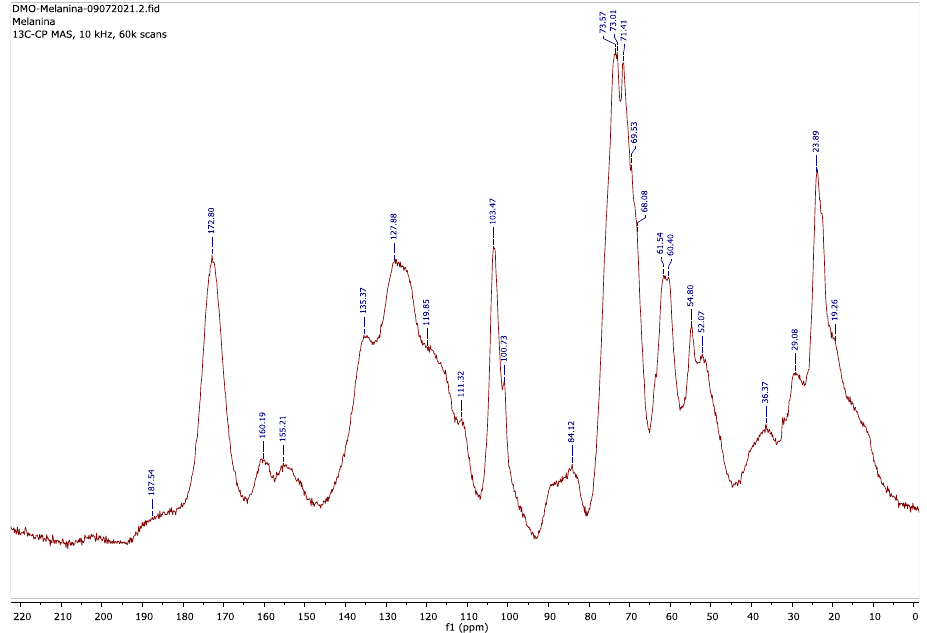
Figure 2. Purified melanin 13 C NMR spectrum of S. cepivorum Berk (400 MHz). Table 2. 13 C NMR resonance assignments for S. cepivorum -extracted melanin.